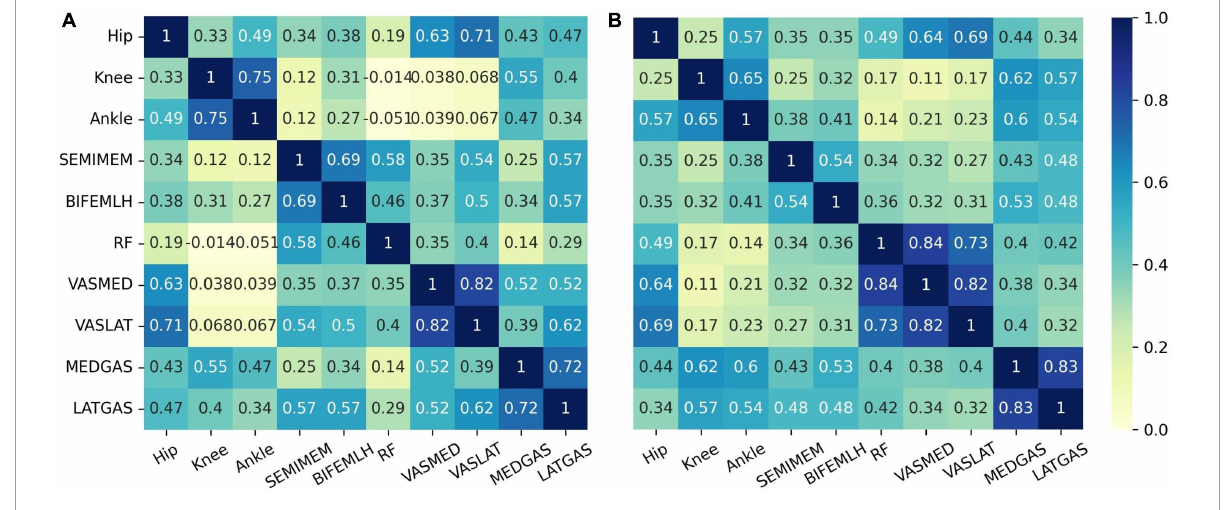
FIGURE6 A heatmap of correlations between groups of variables. (A) the control group, (B) the PFPS pain group.